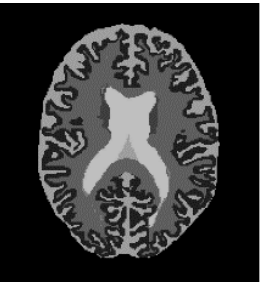
Figure 3. The detailed construction of our STN.